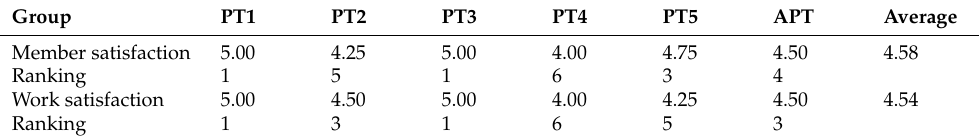
Table 2. Personality Trait Groups’ Self-Rated Performance.